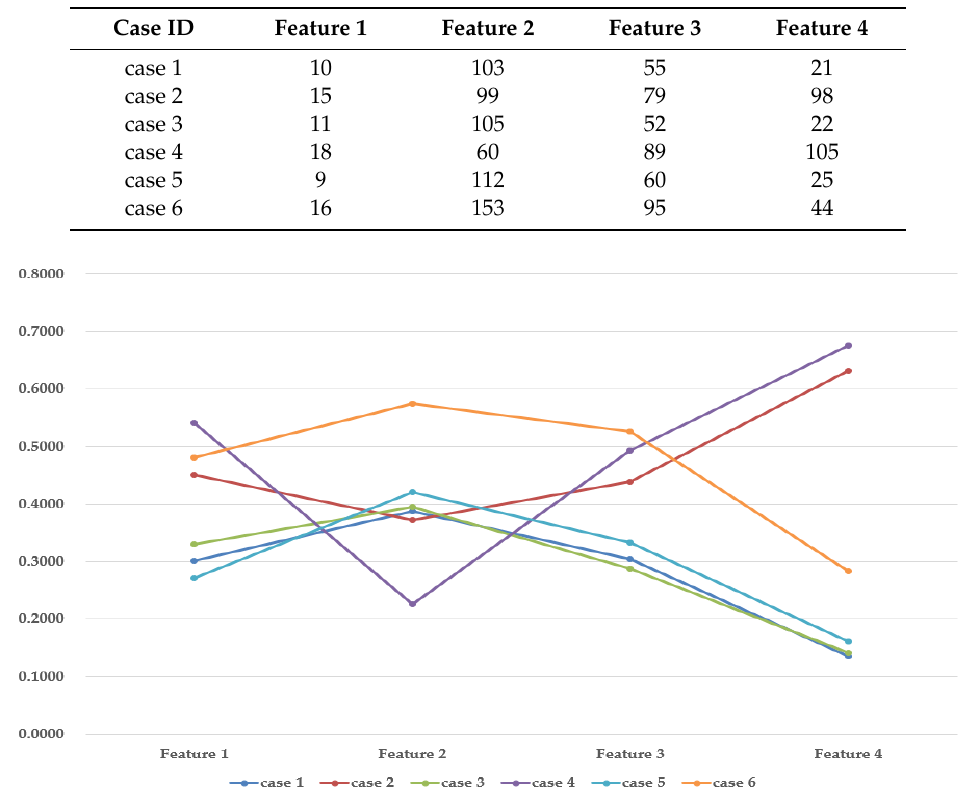
Table 2. An example of a case base.